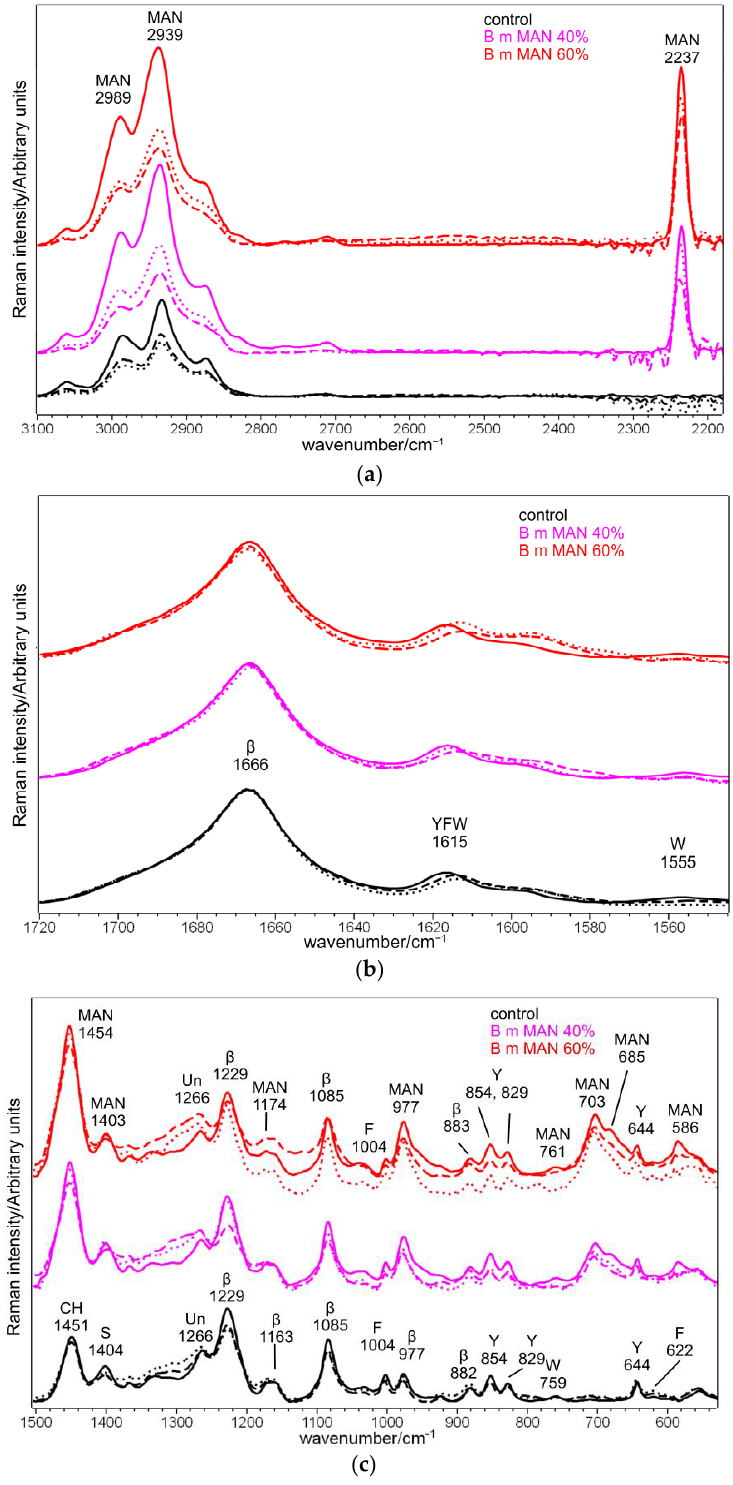
Figure 13. Raman spectra of B. mori silk fibroin control and grafted fibers (MAN 40% and MAN 60% samples only) before (continuous lines) and after immersion in SBF for 7 days (dotted lines) and 28 days (dashed lines) in three different spectral ranges: ( a ) 3100 – 2180 cm −1 , ( b ) 1720 – 1540 cm −1 , and ( c ) 1500 – 530 cm −1 . The spectra are normalized to the intensity of the Amide I band. The main bands assignable to β - sheet (β) or unordered (Un) conformation as well as to tyrosine (Y), phenylalanine (F), tryptophan (W), serine (S), and the grafting agent (MAN) are indicated.